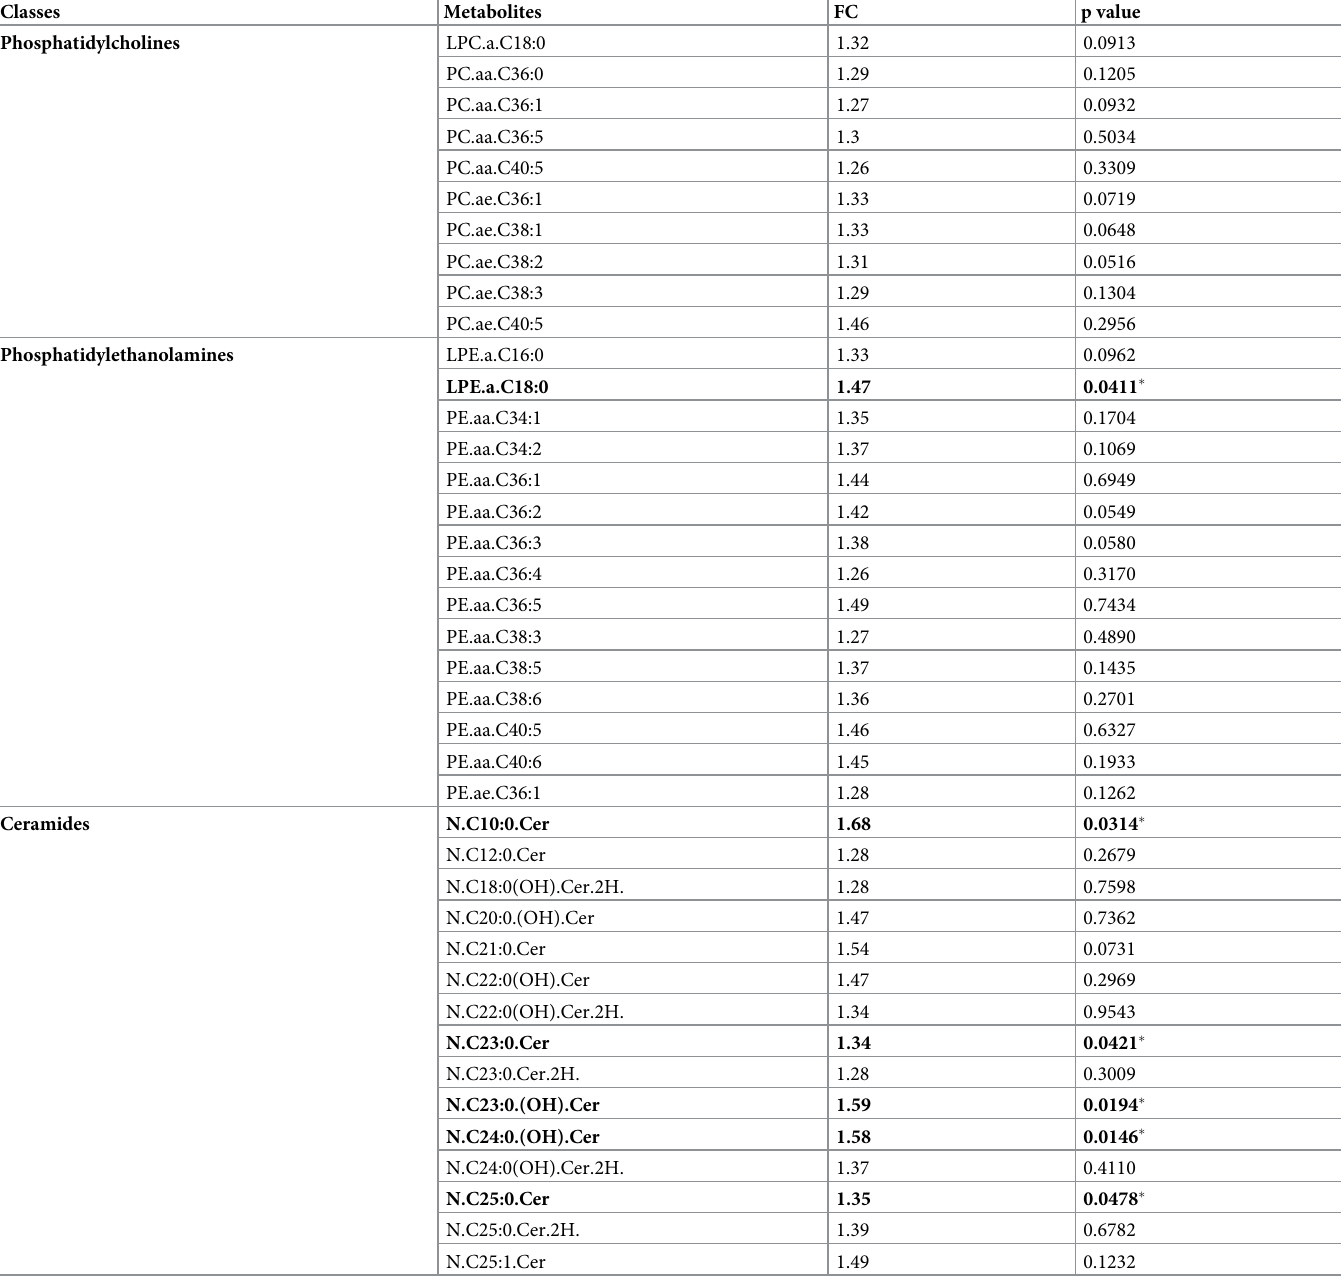
Table 2. Fold change values, referring to the difference between the concentrations of lipids of the women, detected in the post-menopause and pre-menopause groups. São Luı´s, Maranhão, 2013.